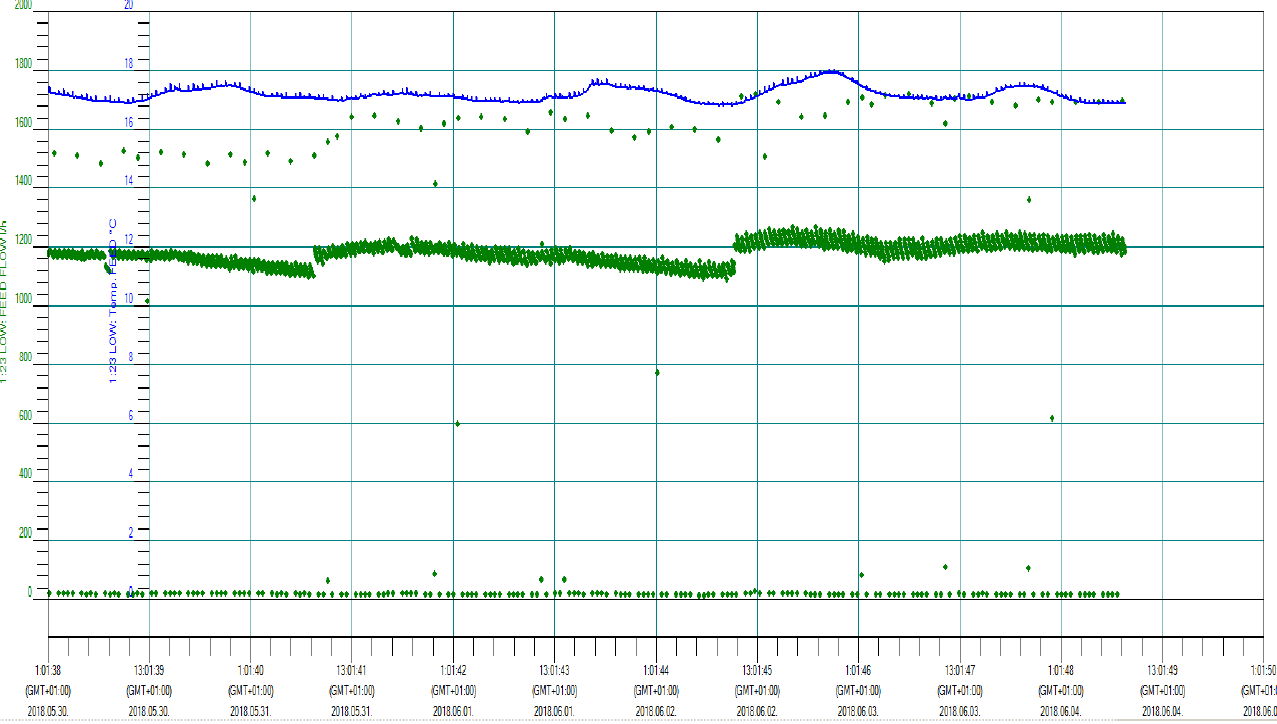
Figure A12. Flow and temperature at 105 l/m 2 h.